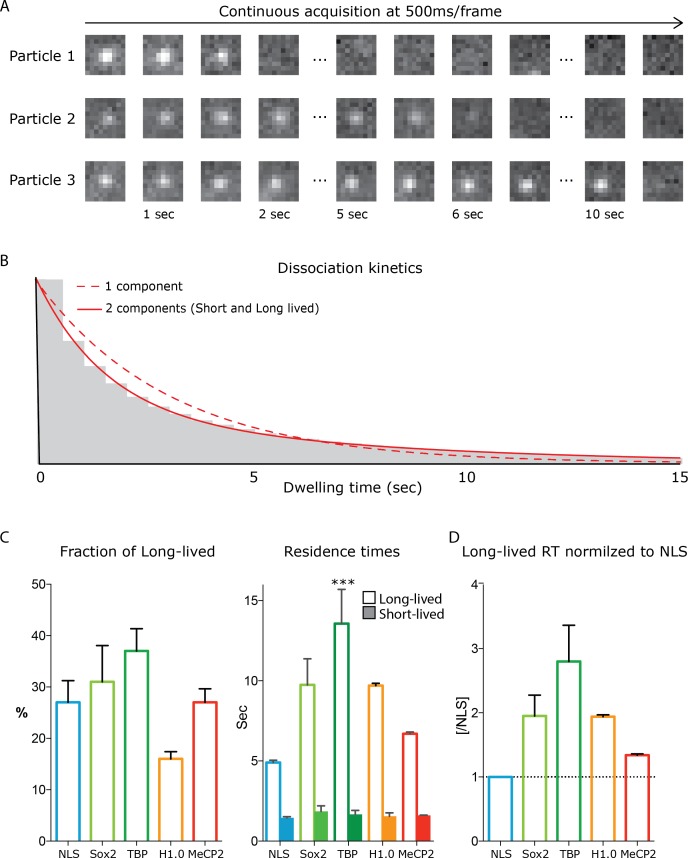
Dwell time analysis of stable single molecules MeCP2 in living neurons reveals highly dynamic interactions with chromatin.Acquisition of stable single MeCP2 molecules in culture GC neurons is achieved by specific labelling MeCP2-HaloTag with JF549 haloligand, photobleached at high laser power to attain single molecule resolution and acquired continuously at low laser power every 0.5 s to selectively detect stable MeCP2 molecules. (A) 0.5 s/frame images of representative stable MeCP2 molecules. (B) Long and Short-lived resident times of stable molecules was determined by fitting a double exponential decay (two components) for their dwell time distribution. (C) The fraction of the molecules that display long-lived dwell times and the Resident Time (RT) of short and long-lived molecules were calculated for individual experiments. Granule cell cultures from wild type animals transfected with construct expressing NLS-HaloTag (turquoise), HaloTag-Sox2 (green), TBP-HaloTag (dark green) and H1.0 (orange) were used as control. Histograms display mean and standard deviation of individual experimental replicates and compare MeCP2 long-lived RT to other nuclear factors by one-way ANOVA with Bonferroni’s multiple comparison test: ** (p<0.005). (D) The long-lived RT for the different proteins normalized to NLS, used as a control protein that engages in no interactions with chromatin.